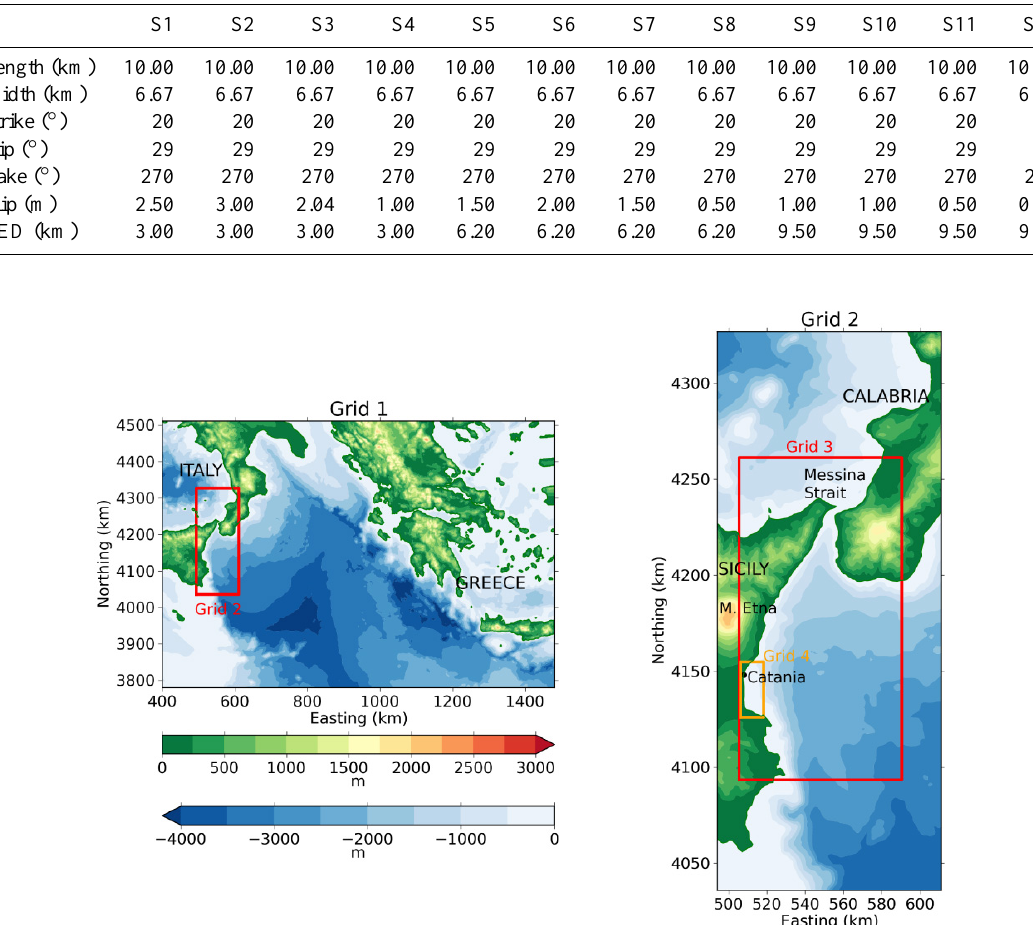
Table 5. Seismic parameters for the tsunamigenic earthquake source based on the one proposed by Valensise et al. (2008). S1 to S4 are the westernmost rectangles from south to north in Fig. 3. The same convention is followed for the central ones (S5 to S8) and the easternmost ones (S9 to S12). UED stands for Upper Edge Depth.